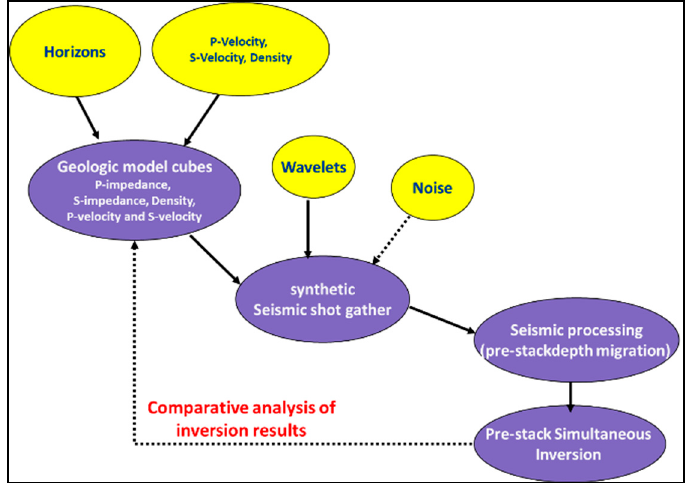
Figure 4. Pre-stack constrained sparse-spike inversion workflow.